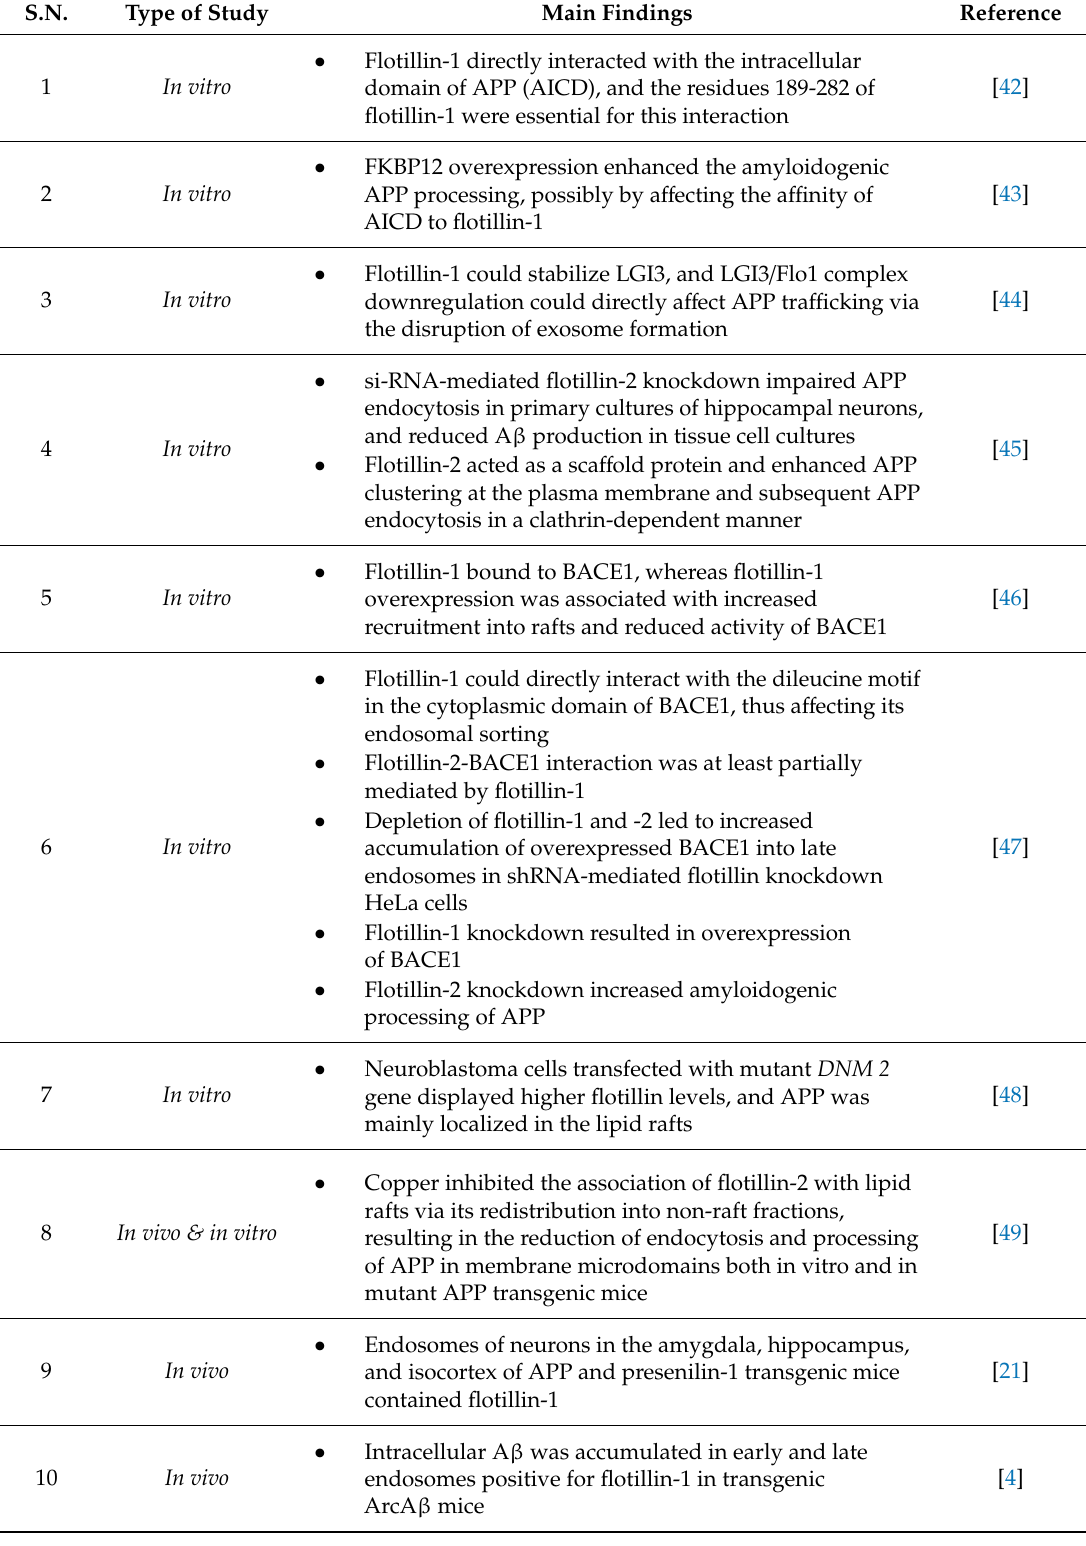
Table 1. In vitro and in vivo evidence about the role of flotillin in Alzheimer’s disease (AD).